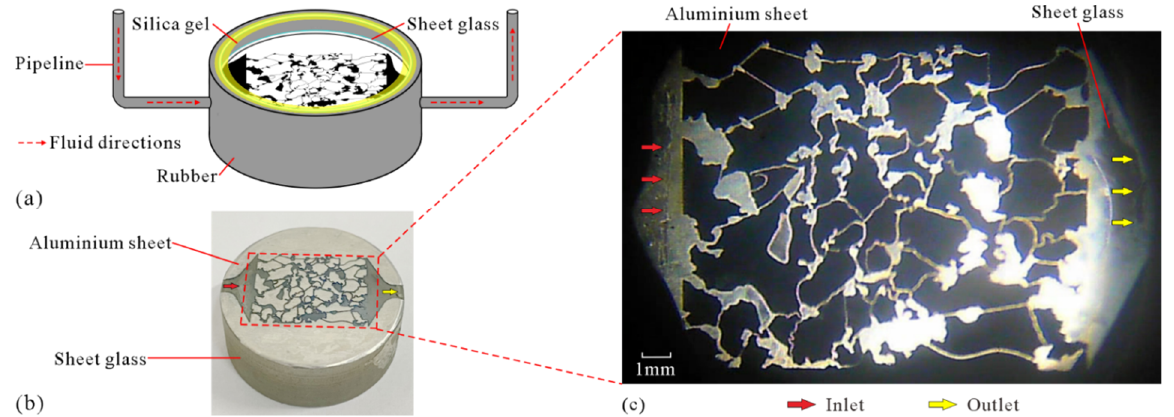
Figure 4. MEM and photos taken under microscope: ( a ) schematic diagram of MEM after encapsulation; ( b ) MEM attached to a single piece of glass; ( c ) image of MEM under microscope.